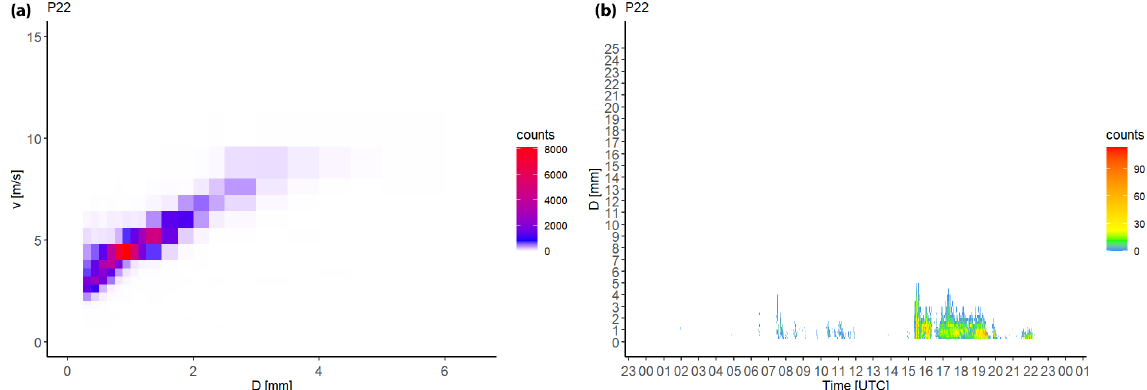
Figure 4. Example of disdrometer data for 22 June 2011 at site 3 (disdrometer P22). (a) Scatter plot of the number of drops according to the velocity (terminal fall speed) and size (equi-volumetric drop diameter) classes. (b) Temporal evolution of the DSD.